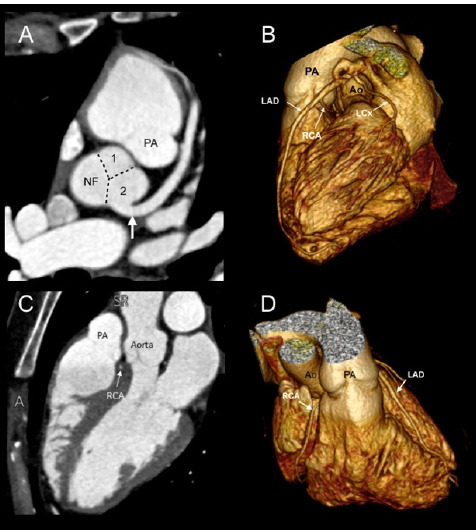
Figure 3. Case 27. CCTA in a 37-year-old woman undergoing preoperative evaluation for an atrial septal defect. ( A ) Axial image depicting the origin of the SCA (arrow) from sinus 2. ( B ) A 3D volume- rendered image showing that the RCA originates from the middle segment of the LAD with an interarterial course. According to the Imaging Leiden Convention, the anatomy is 2R*LCx; by Lipton classification, it is LIIB. ( C , D ) The RCA follows a course between the aorta and pulmonary artery (level of right ventricular outflow tract). Ao: Aorta. LAD: Left anterior descending coronary artery. LCx: Left circumflex. NF: Non-facing sinus. PA: Pulmonary artery. RCA: Right coronary artery.